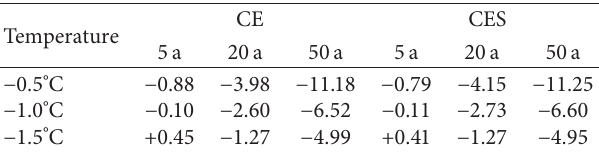
Figure 10: Variation in soil temperature beneath the TE in October of the 5th, 20th, and 50th years under different mean annual ground temperatures: (a) − 0.5 ° C, (b) − 1.0 ° C, and (c) − 1.5 ° C. Table 4: Variation of the table permafrost beneath the CE and CES under different mean annual ground temperatures (unit: m).